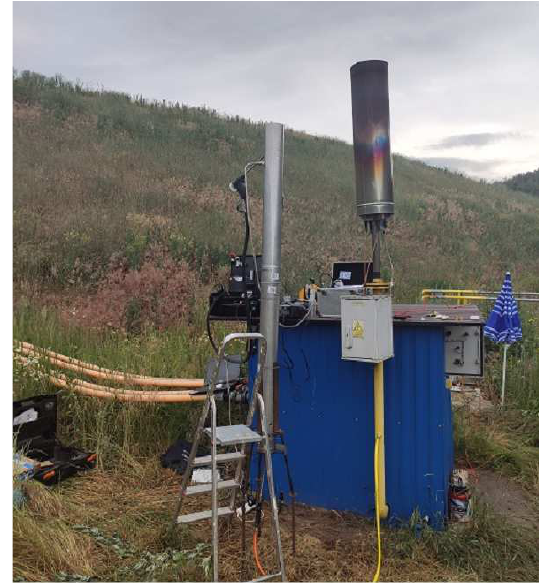
Figure 2. Measuring stand at waste landfill in Kiełcz. Measurement points have been shown graphically in Figure